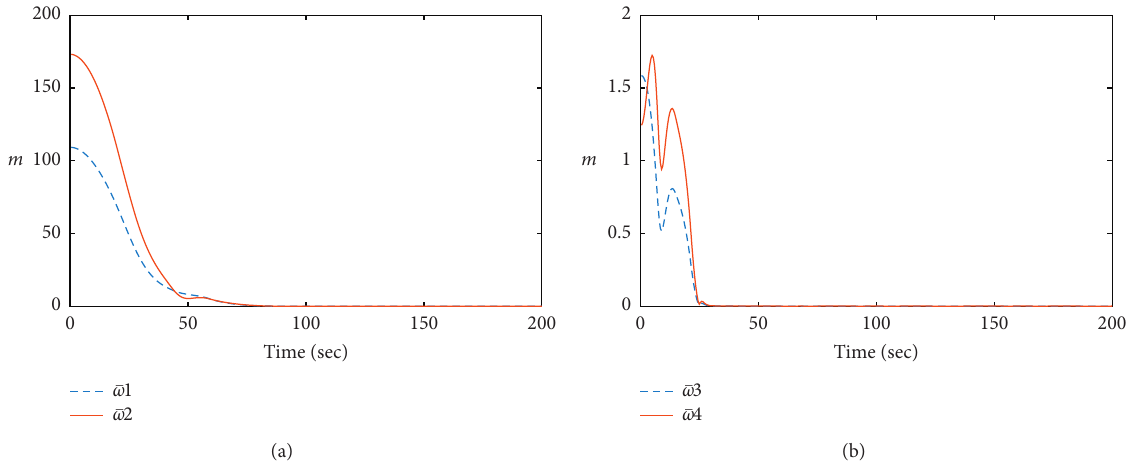
Figure 9: The curves of the performance indexes ϖ 1 to ϖ